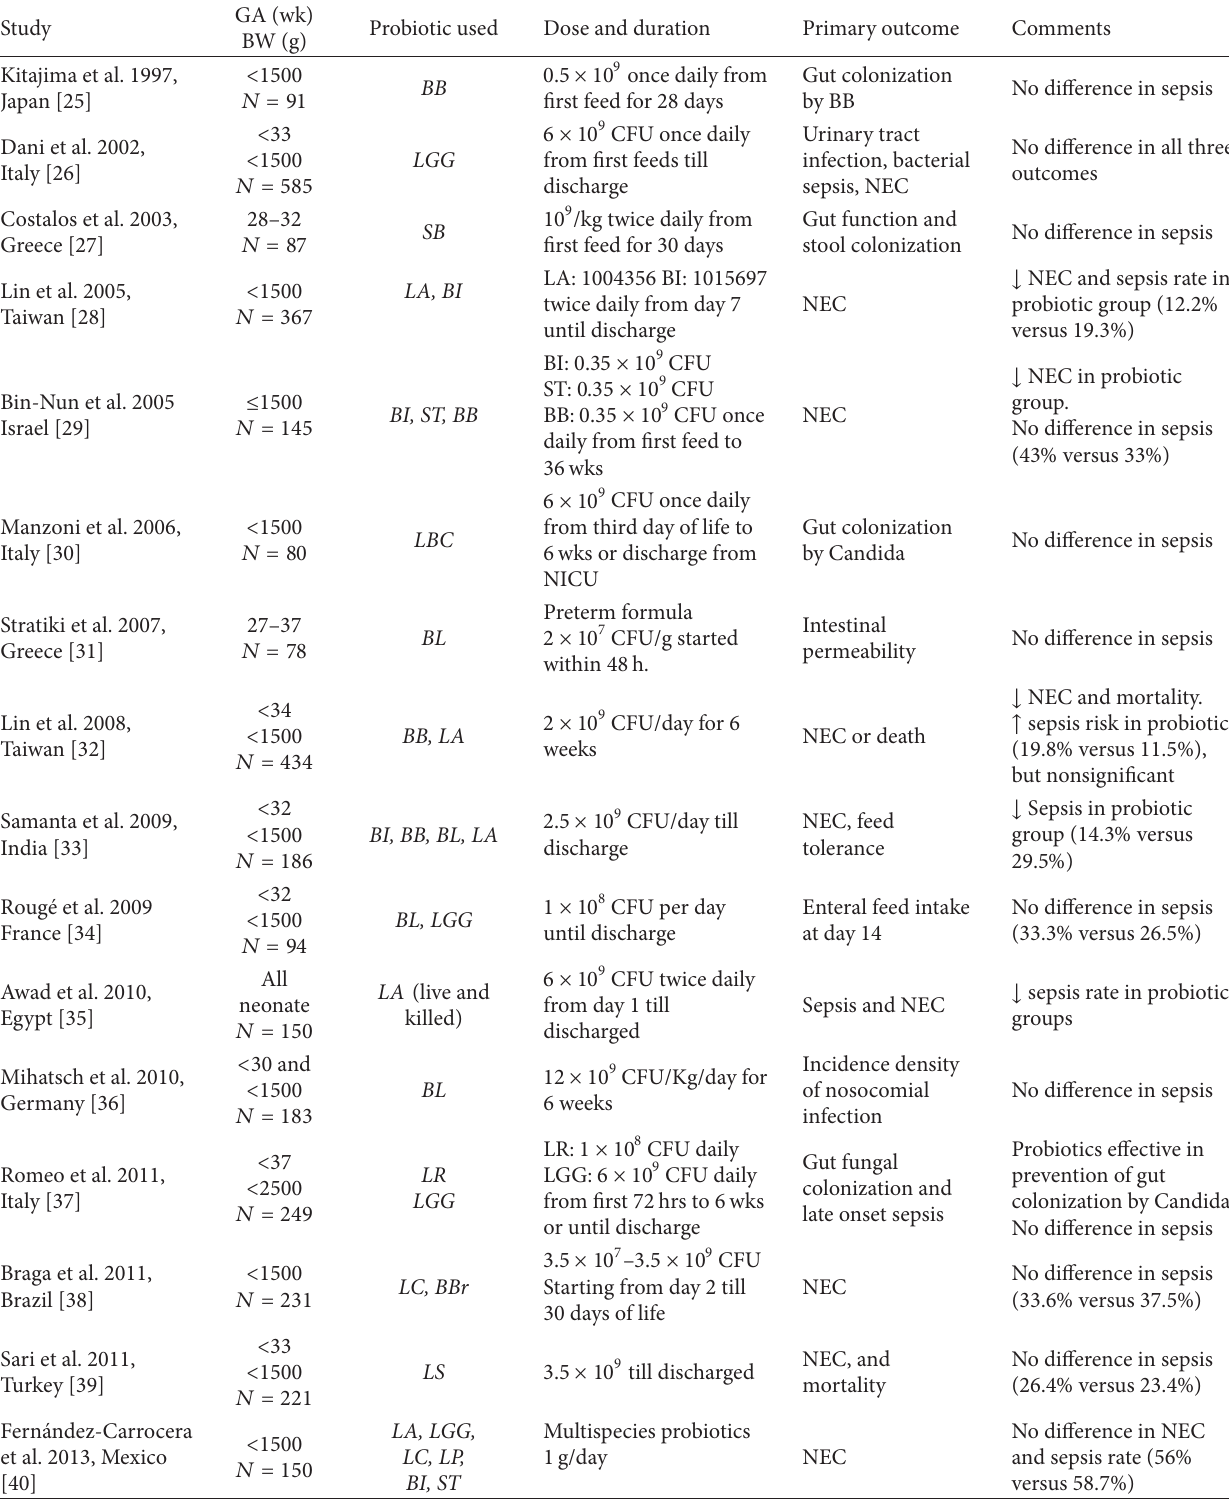
T 1: Clinical trials of probiotics for prevention of NEC and sepsis in